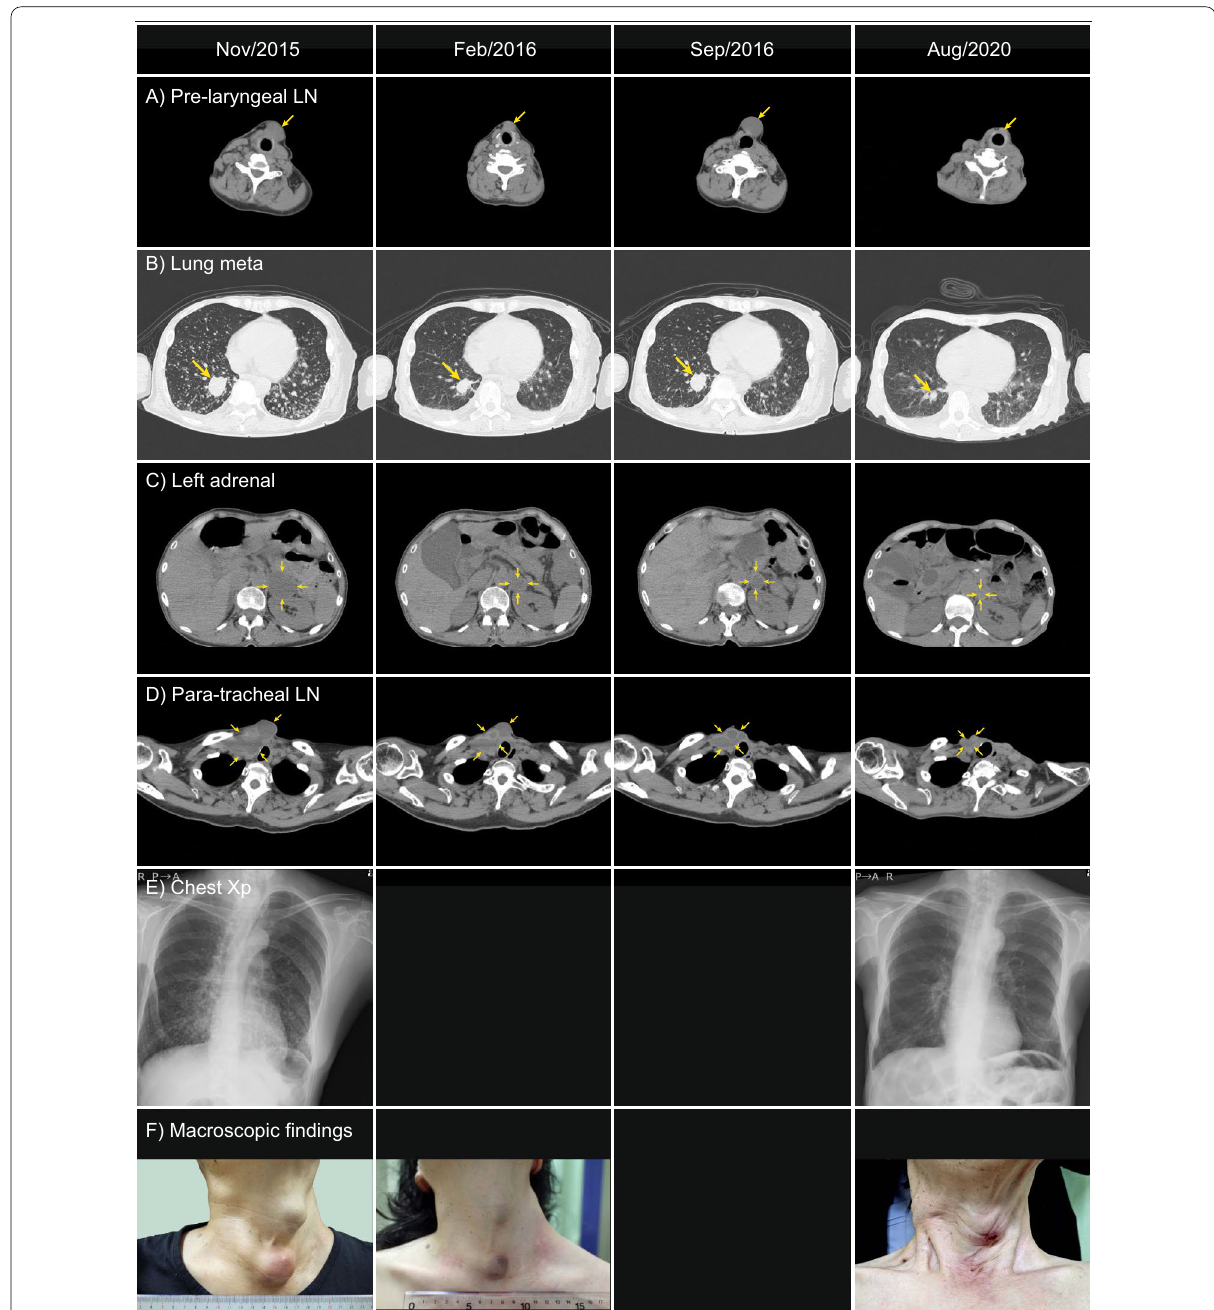
Fig. 2 Changes in images from computed tomography (CT) scans ( A – D ) and chest X-rays (Xp) ( E ), and macroscopic appearances of the patient’s neck ( F ) during her clinical course. Enlarged pre-laryngeal lymph node (LN), lung metastasis, left adrenal metastasis, and cystic lymph nodes in the neck and mediastinum are shown in A – D ,